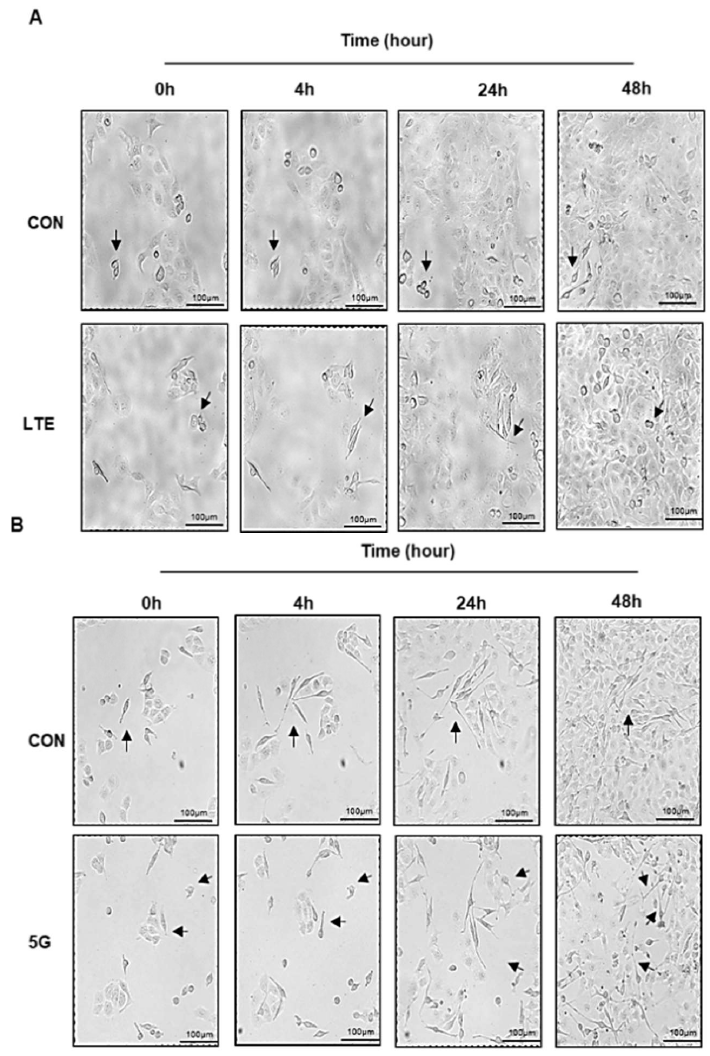
Figure 3. Effects of EMFs on the dendrite formation in co-cultured cell lines. MNT-1 and HaCaT cells were co-cultured in 8-well chamber and then exposed to either LTE or 5G for 4 h per day. ( A ) Dendrite formation changes on MNT-1/HaCaT co-culture cells after LTE exposure. ( B ) Dendrite formation changes on co-culture cells after 5G exposure. Black arrows indicated the representative dendrite formation as the cultivation time